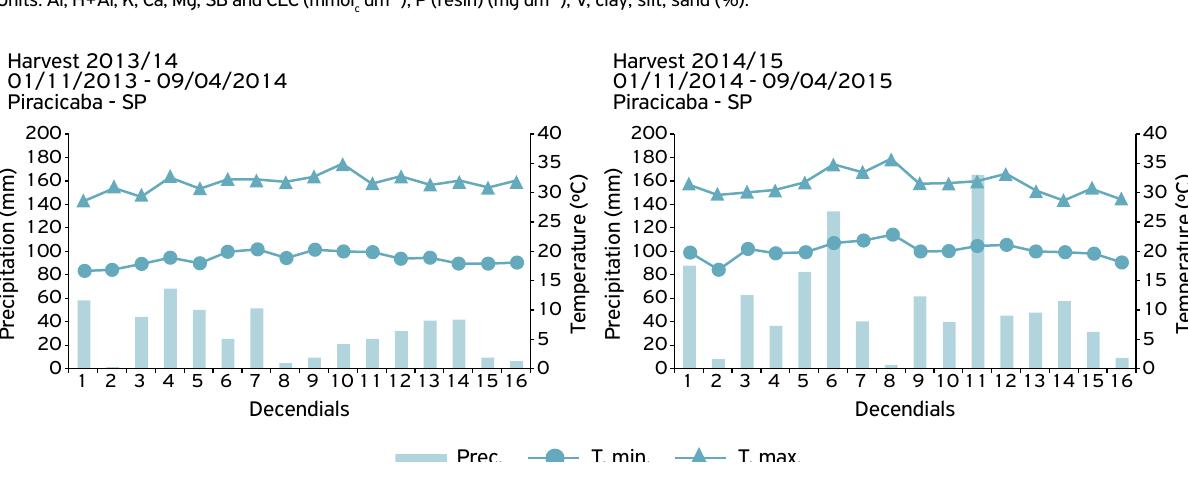
dm ‑3 ); P (resin) (mg dm ‑3 ); V, clay, silt, sand (%). c